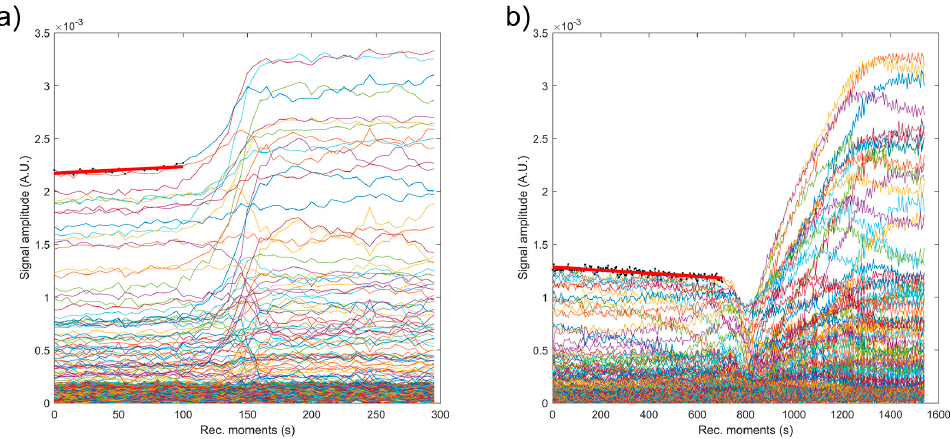
Figure 4. Evolution in time of the amplitudes of the selected echo, for the samples S1 ( a ) and S2 ( b ).